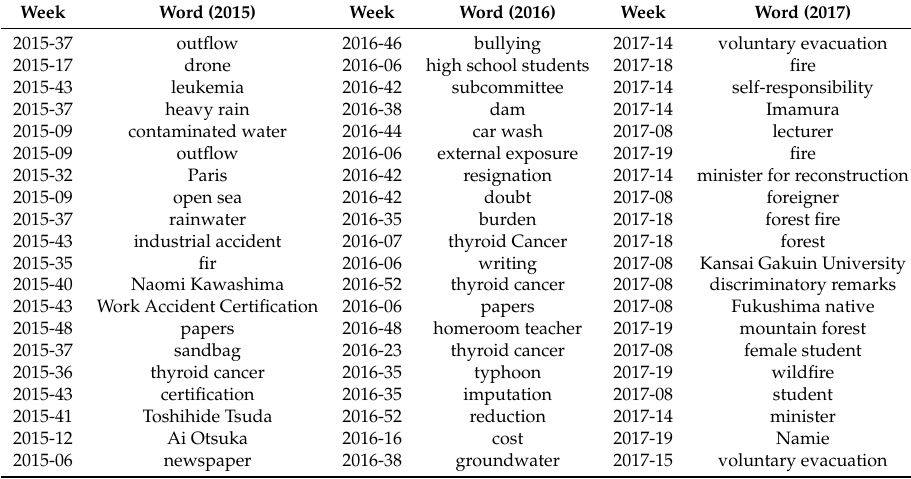
Table 3. Top 20 popular topics for which the scores calculated using the proposed method were high for each year, from 2015 to 2017.